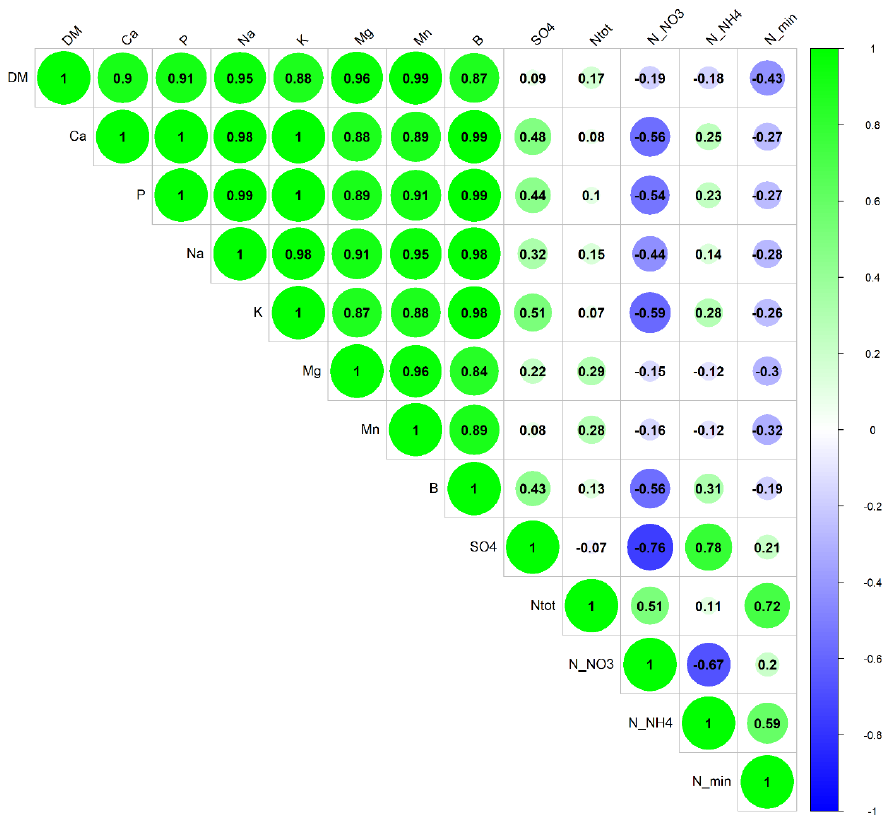
Figure A1. Pearson’s Correlation matrix for properties of digestate treatments. Displayed values = correlation coefficient r .